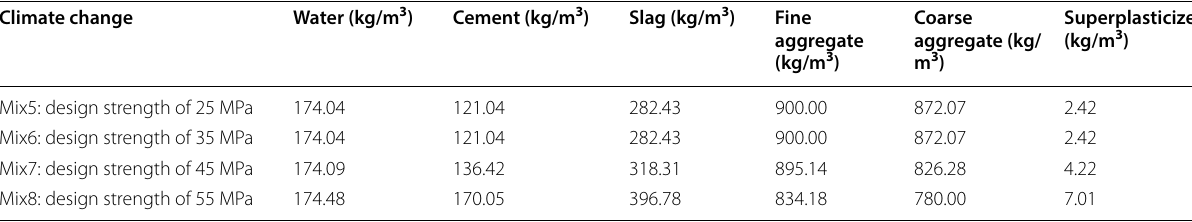
Table 7 Mixtures of concrete under a climate change